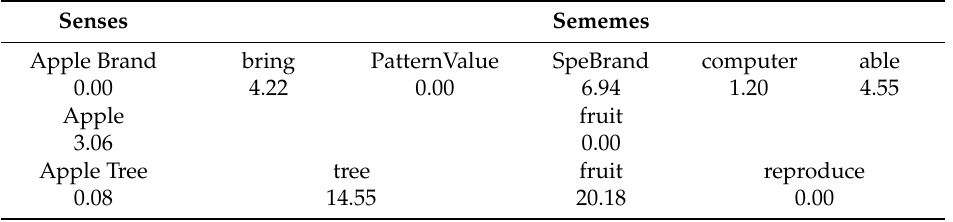
Table 6. “I just hit you with an apple ( Apple)